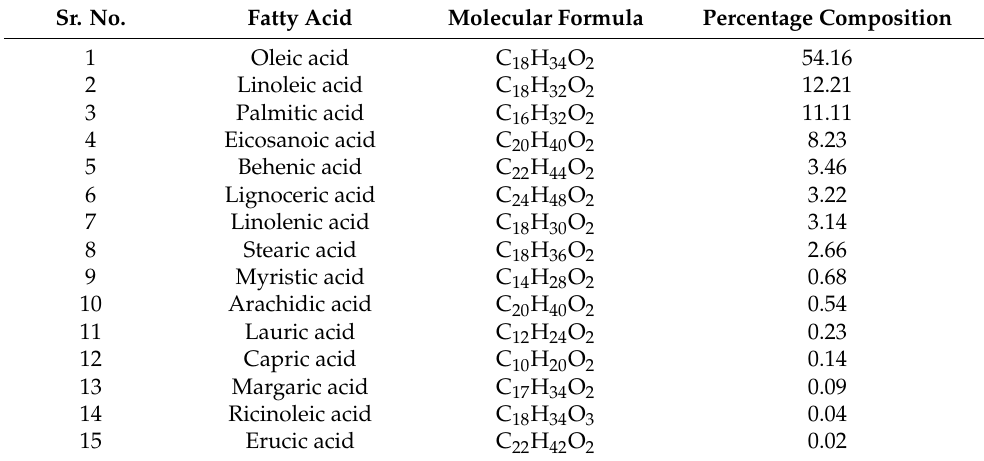
Table 1. Fatty acid profile of Pongamia pinnata seeds oil.